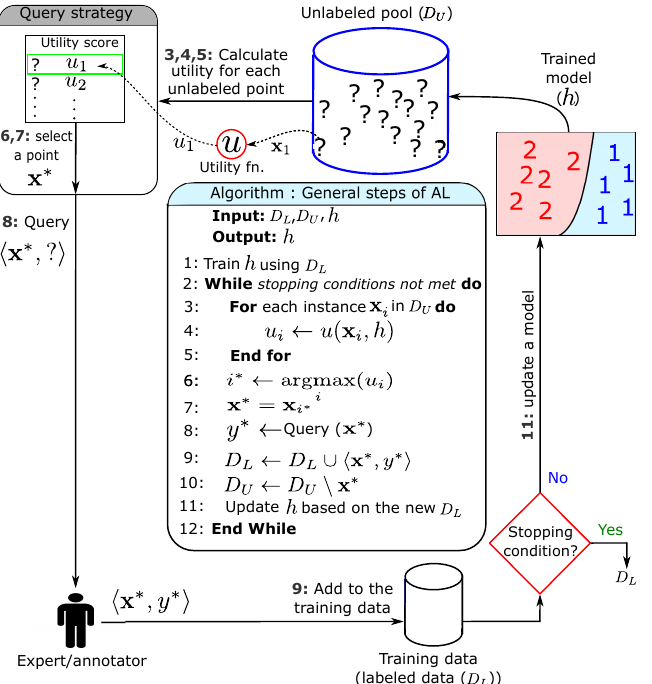
Figure 3. An illustrative example to show the steps of the pool-based active learning scenario. In some studies, as in [41], the combination of the pool-based and the membership query synthetic scenarios solved the problem of generating arbitrary points by finding the nearest original neighbours to the ones that were generated